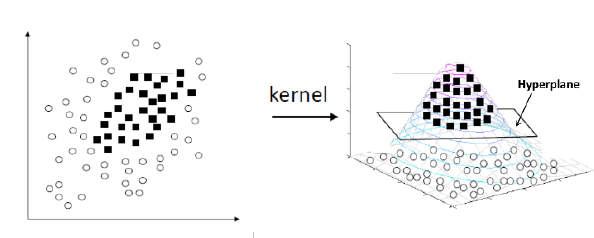
Figure 3. Kernel Trick for non-linearly separable data Table 2. Few popularly used